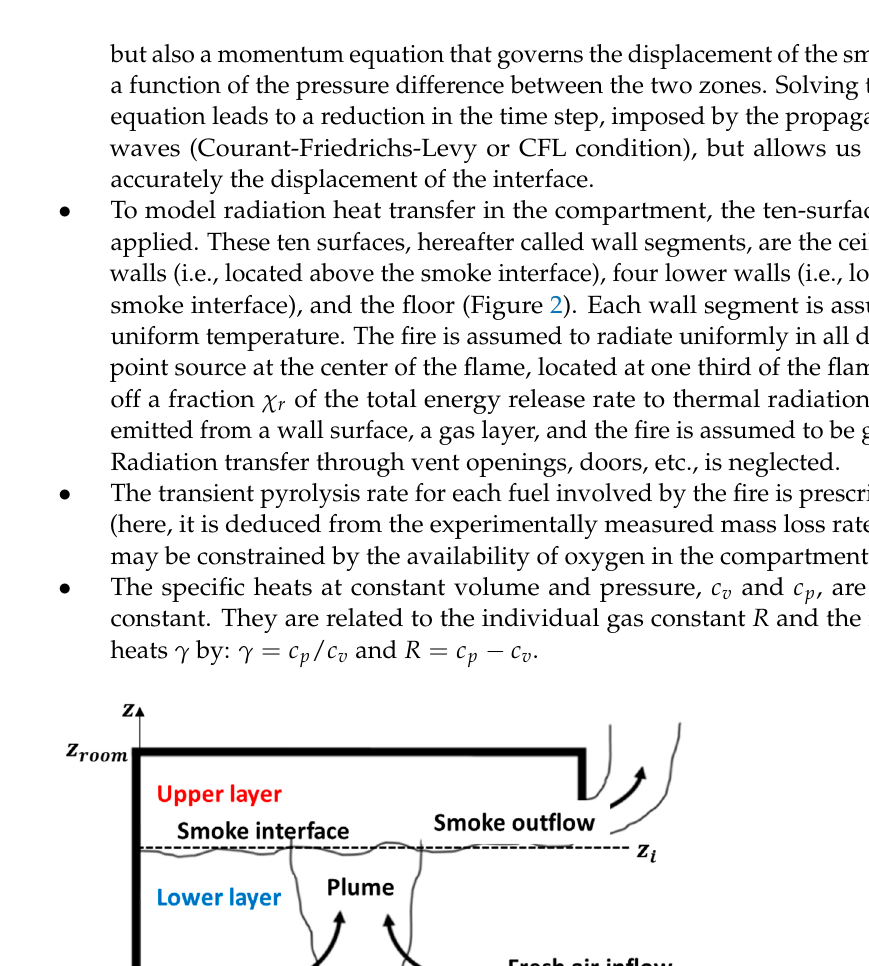
(cid:3033)(cid:3036)(cid:3045)(cid:3032) .